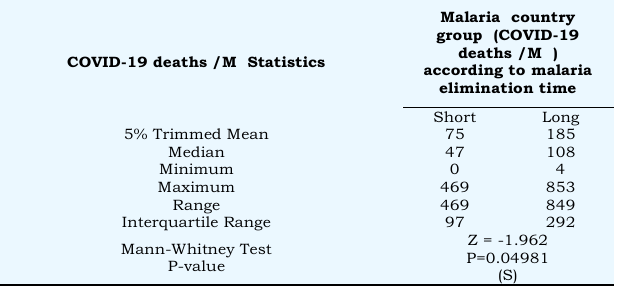
Table 2 Descriptive Statistics of (COVID -19 Deaths/M) and testing of all probable combinations due to elimination of malaria periods for studied